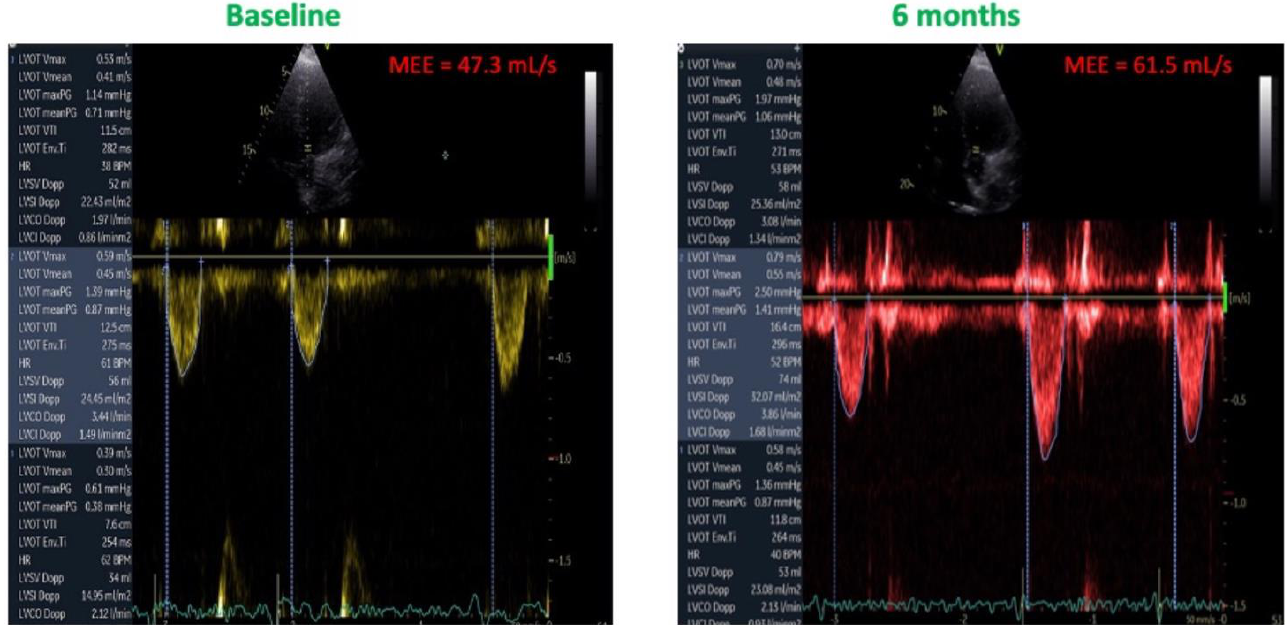
Figure 4. Effects of CCM therapy on MME. Note the increase in stroke volume without an increase in heart